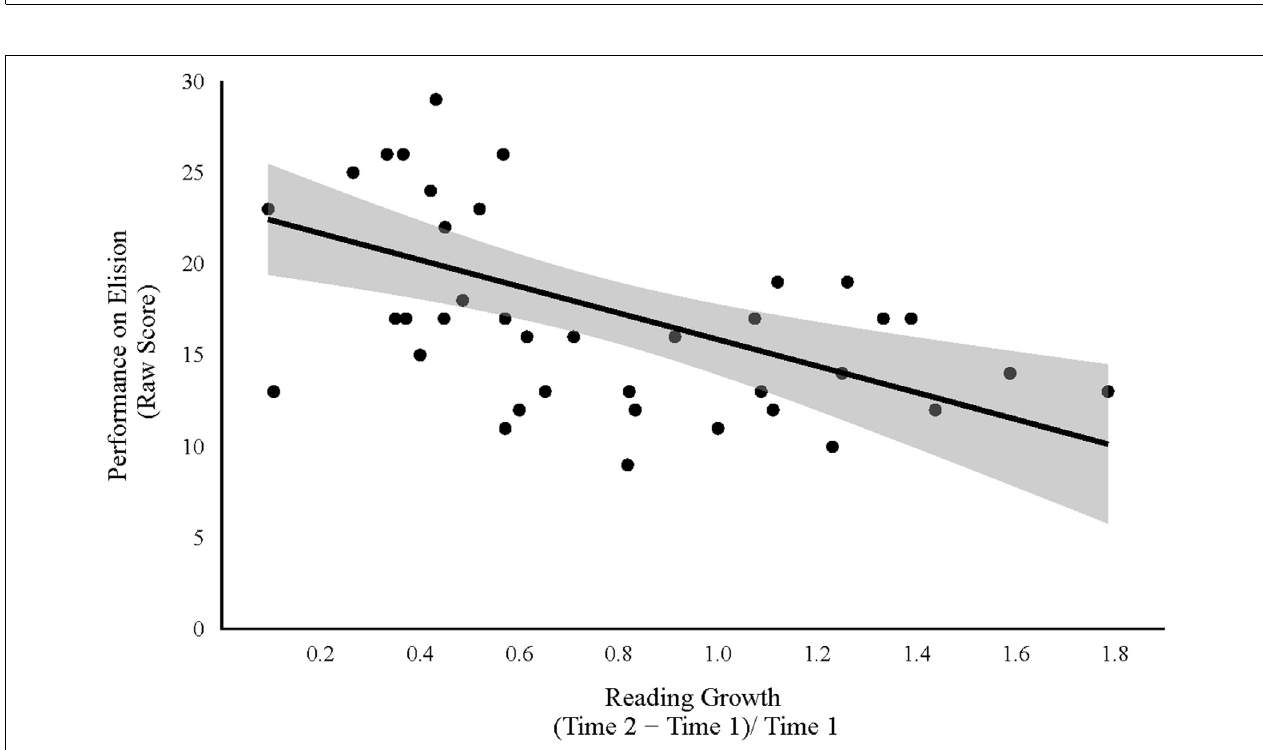
FIGURE 3 | Relation between phonological skill (as measured by performance on the Elision subtest) at 5-to-6 years old (Time 1) and growth in reading skill from 5-to-6 years old to 7-to-8 years old (Time 2). The shaded region depicts a 95% confidence interval.